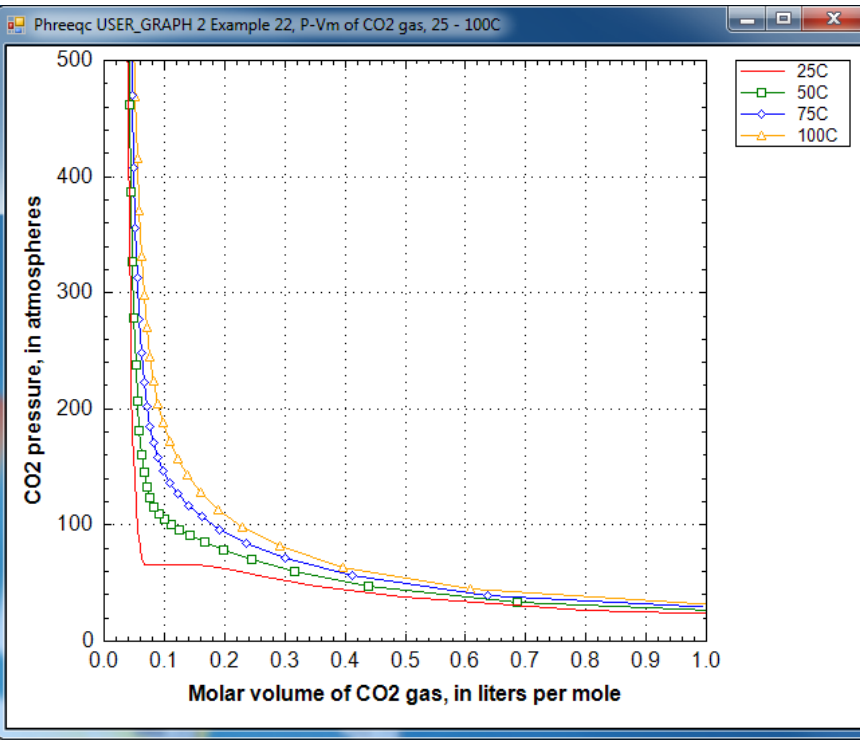
Figure 28. Pressure-volume curves of CO 2 gas at 25, 50, 75 and 100 °C. The calculated points are omitted at 25 °C to show more clearly how the curve flattens when the gas